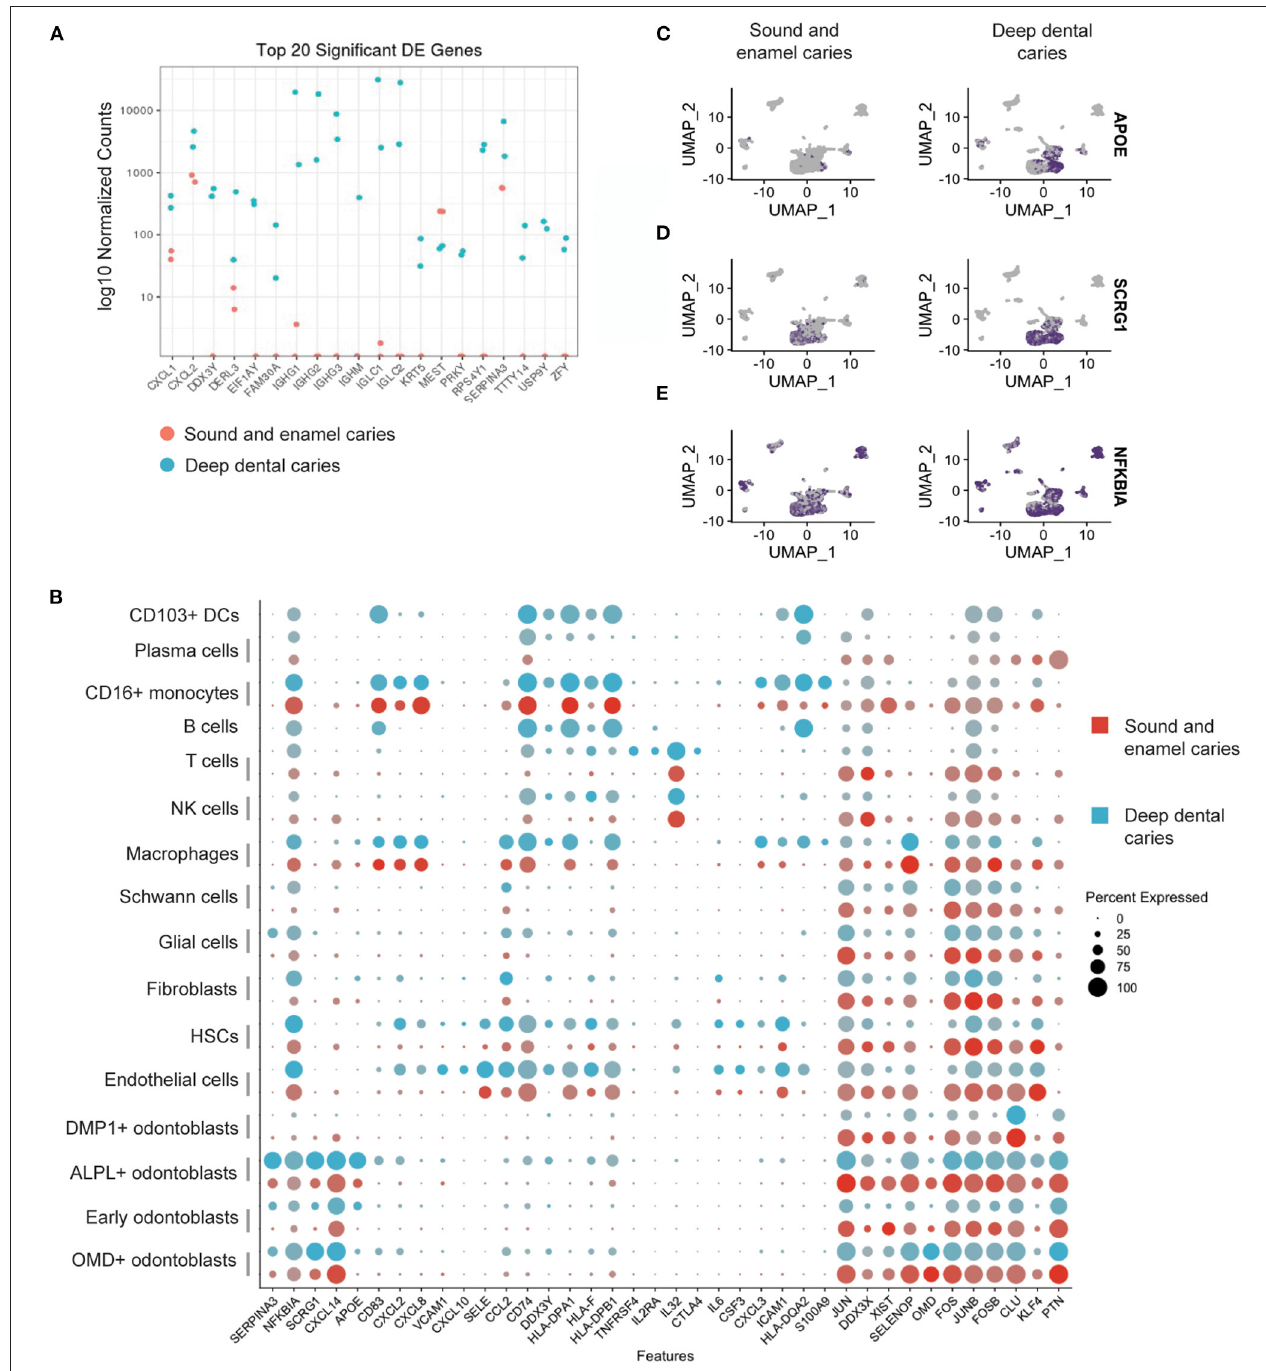
FIGURE 3 | Differential gene expression analysis in dental pulp from sound tooth and enamel caries vs. deep dental caries. (A) Pseudo-bulk DEG analysis showing average log normalized counts of the top 20 DEGs. (B) Dot plots showing expression levels of representative genes. (C–E) Feature plots showing the expression levels of a representative regulatory gene, APOE (C) , mineralization gene, SCRG1 (D) and pro-inflammatory gene, NFKBIA (E) .